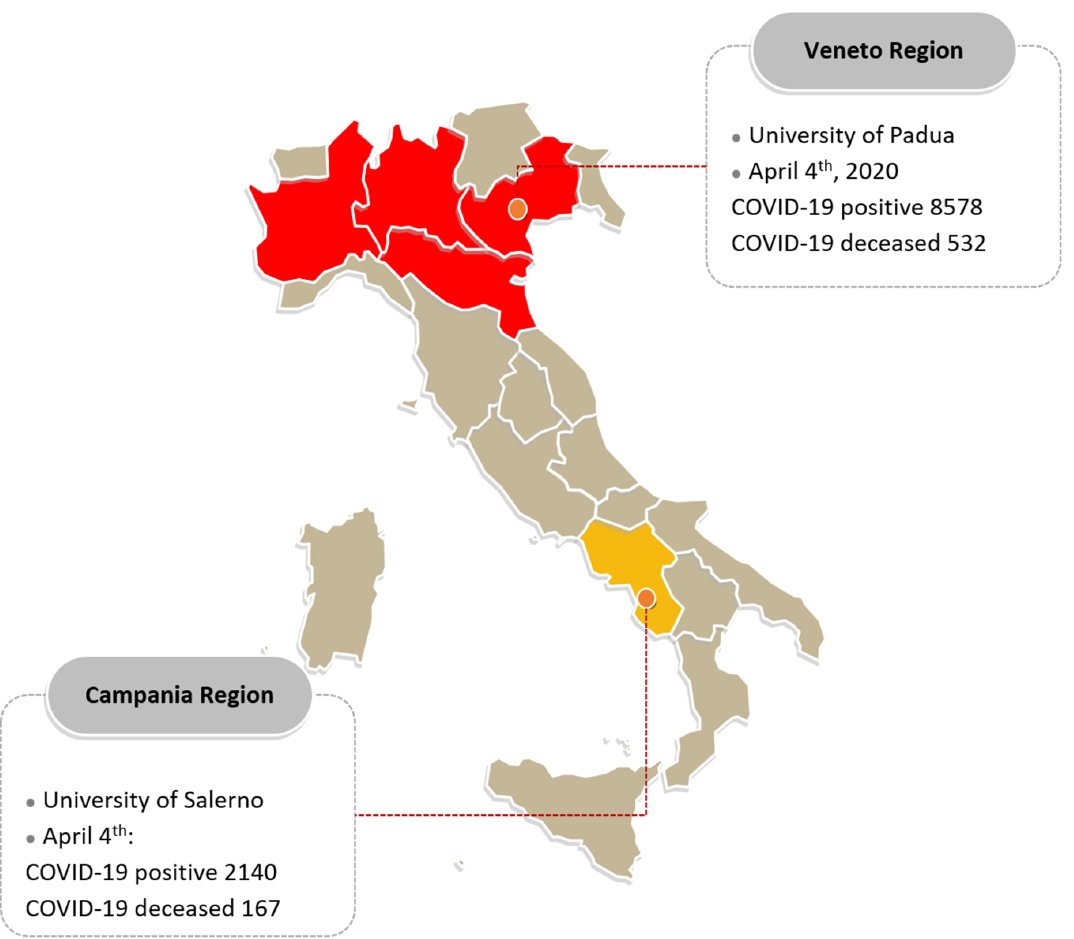
Figure 1. Italy map with COVID-19 spread updated on 4 April, 2020 in Italian regions of Veneto and Campania.